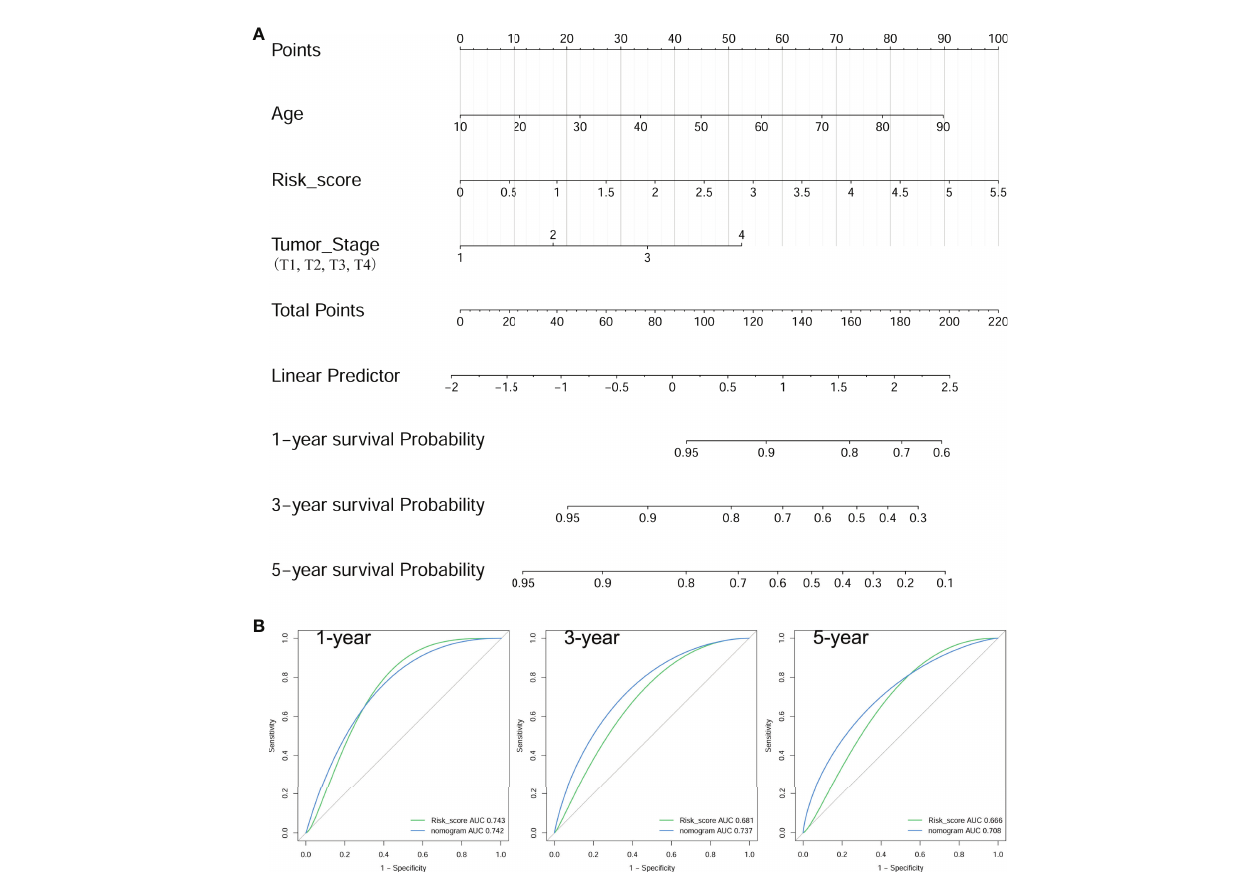
FIGURE 8 | Construction of a nomogram for PFS in PTC patients with RAI therapy. (A) The baseline nomogram from age, risk score, and tumor stage. (B) tROC curves of the nomogram for predicting the PFS rates at 1, 3, and 5